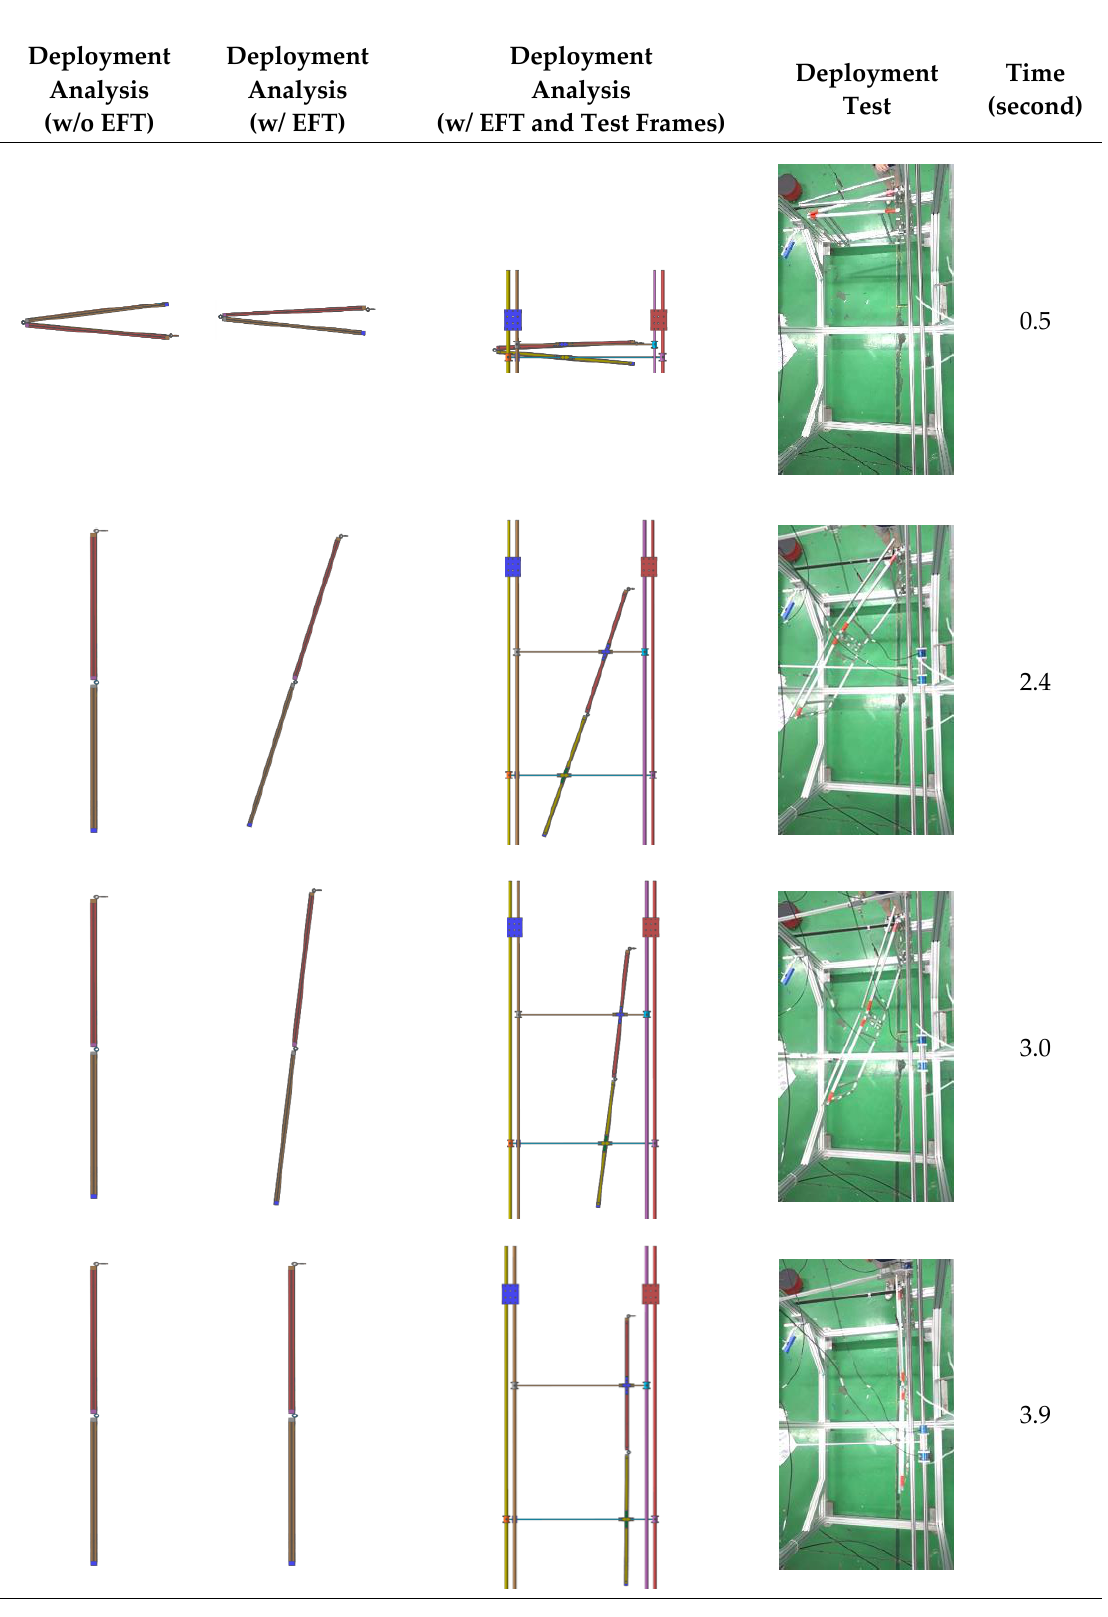
Figure 12. Comparison of the deployed motion history for case 1.